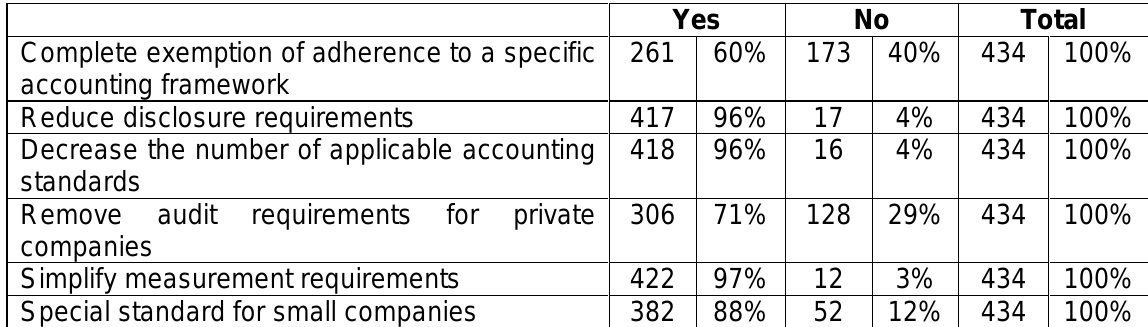
Table 2: Lessening the burden of preparing financial